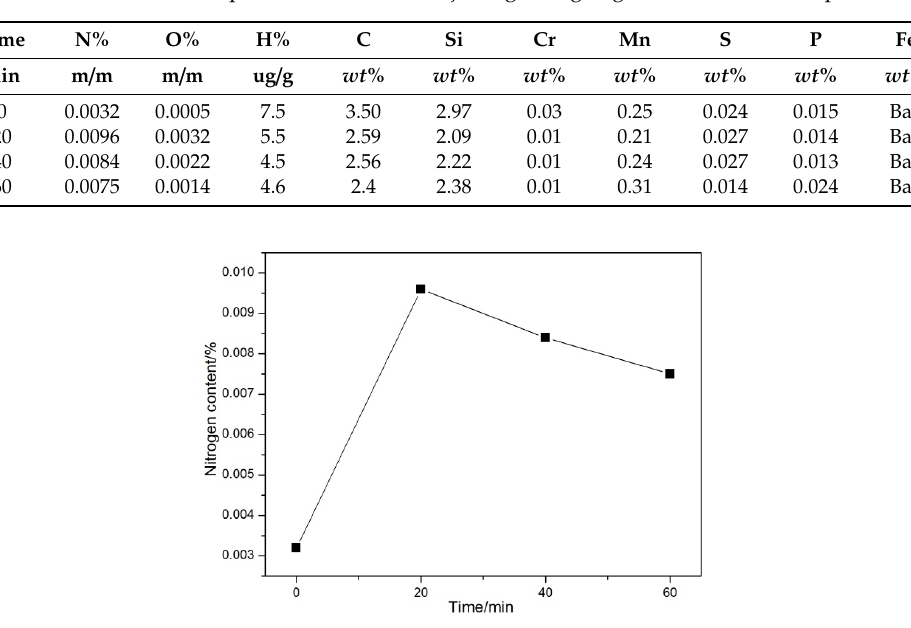
Figure 7. Content of DI after injecting nitrogen gas for different time periods.